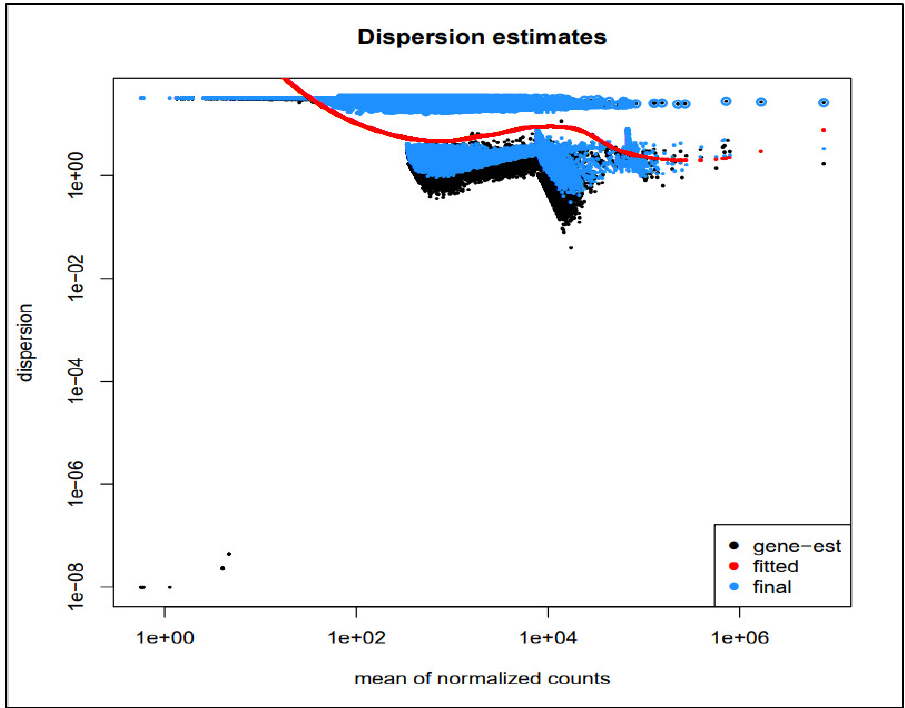
Figure 3. Dispersion plot for the mean of normalized read counts.